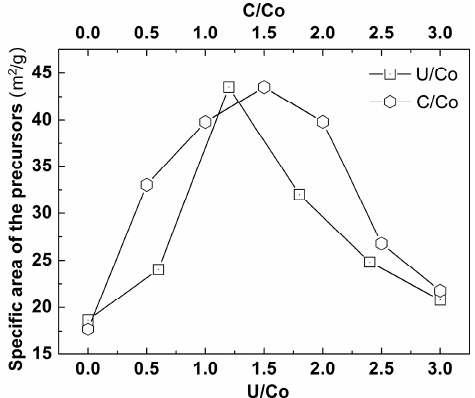
Figure 2. Dependence of specific surface area of the combusted powder on the U/Co and C/Co molar ratios of the solution precursor.